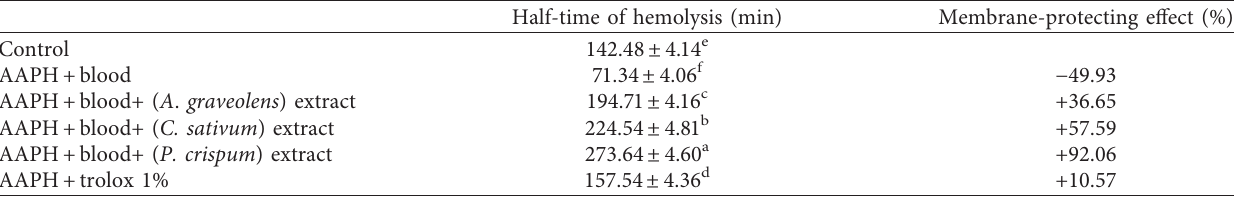
Table 3: Antihemolytic activity and membrane-protecting effect induced by plant extracts.